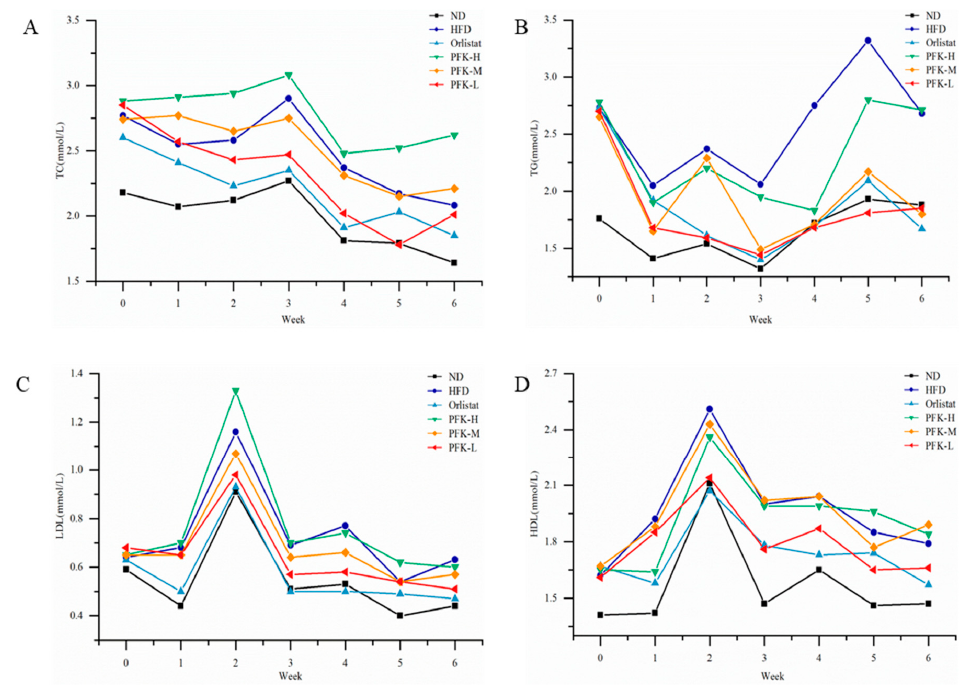
Figure 3. Effects of PFK on serum lipids. ( A ) TC, ( B ) TG, ( C ) LDL-C, ( D ) HDL-C. ND group: normal diet + 0.5% CMC-Na; HFD group: high-fat diet + 0.5% CMC-Na; Orlistat group: high-fat diet + 20 mg/kg orlistat; PFK-H group: high-fat diet + 400 mg/kg krill oil, 40 mg/kg fucoxanthin, 200 mg/kg phycobiliprotein; PFK-M group: high-fat diet + 200 mg/kg krill oil, 20 mg/kg fucoxanthin, 100 mg/kg phycobiliprotein; PFK-L group: high-fat diet + 100 mg/kg krill oil, 10 mg/kg fucoxanthin, 50 mg/kg phycobiliprotein. Table 2. Effects of PFK complex on risk